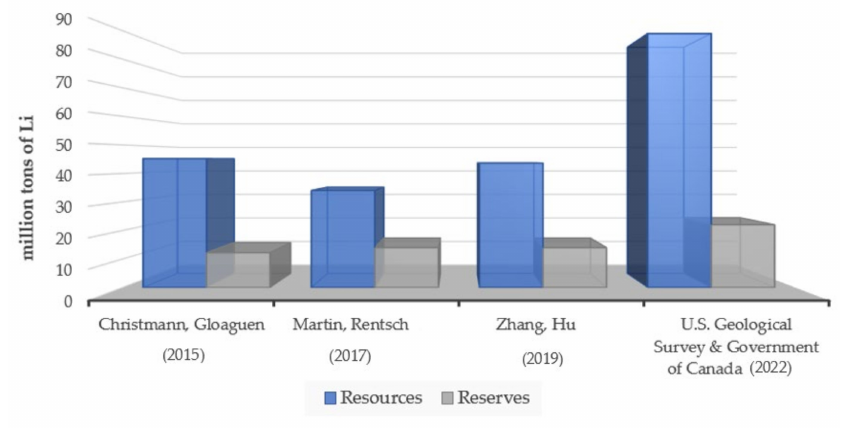
Figure 1. Lithium global availability